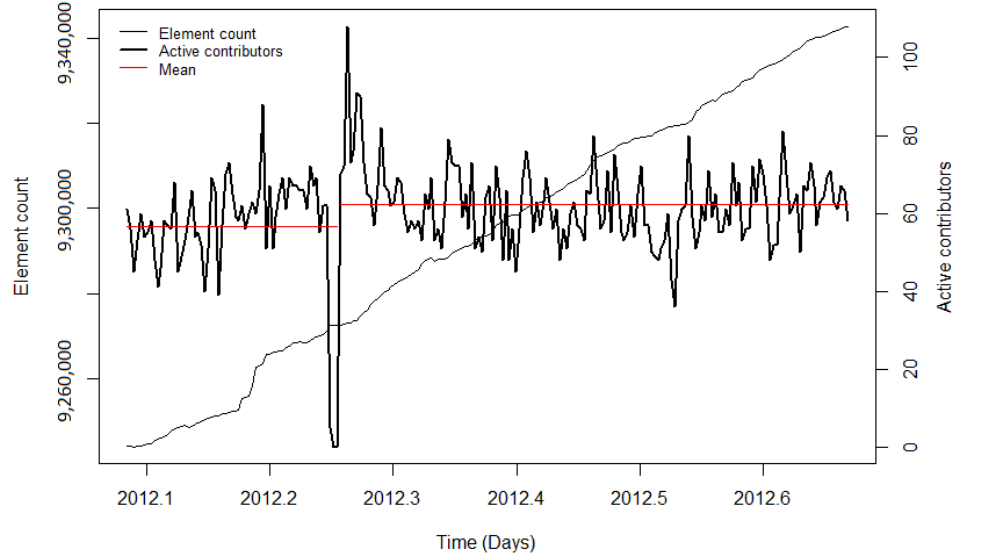
Figure A4. Contributor activity during the observation period without a large data import in the Netherlands.